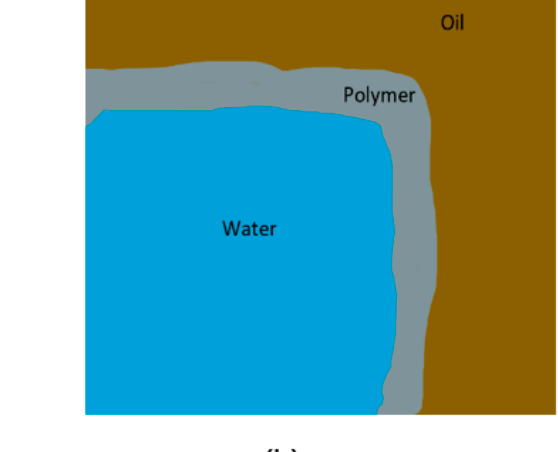
Table 7. Rheology parameters of biopolymers and HPAM.